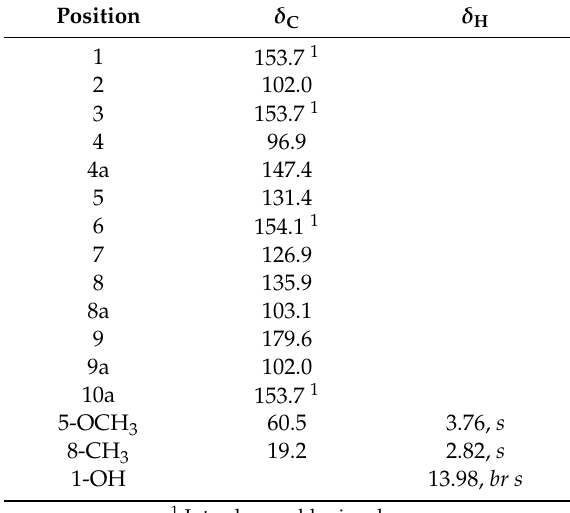
Table 1. 13 C- and 1 H-NMR Spectroscopic Data (125 / 500 MHz) for 1 in DMSO- d 6 ( δ in ppm).